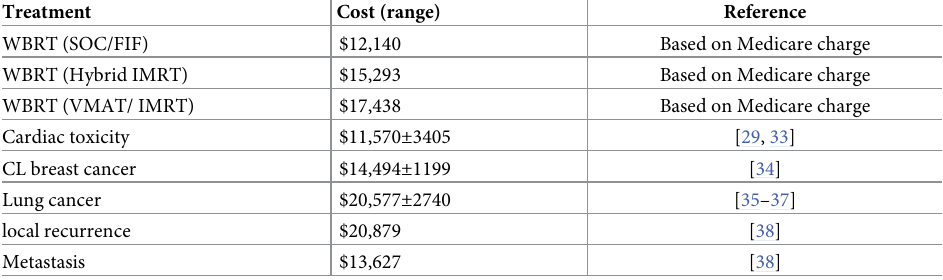
Table 2. Treatment